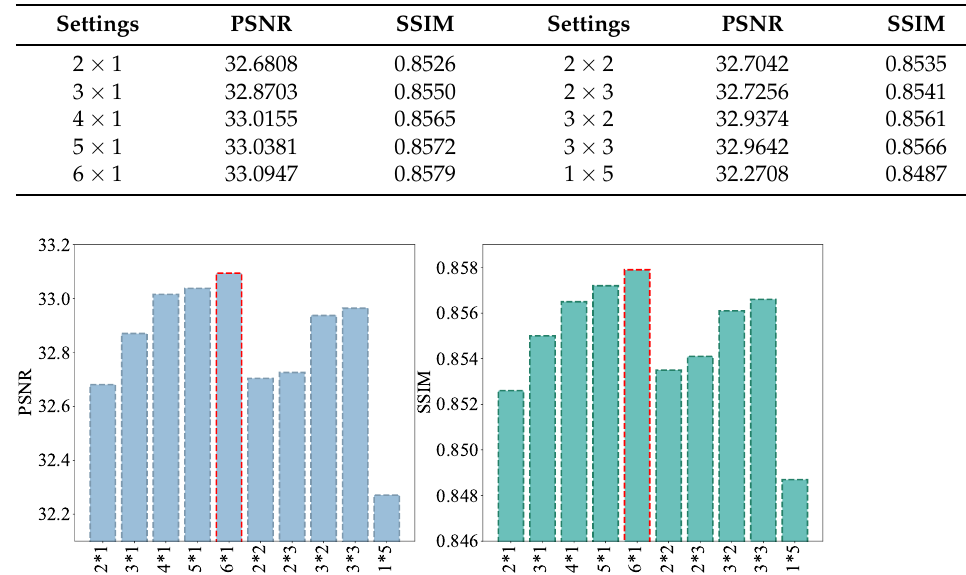
Table 8. The average PSNR and SSIM for verification of the best model settings. Each PSNR and SSIM is the average of the three datasets and seven ratios.